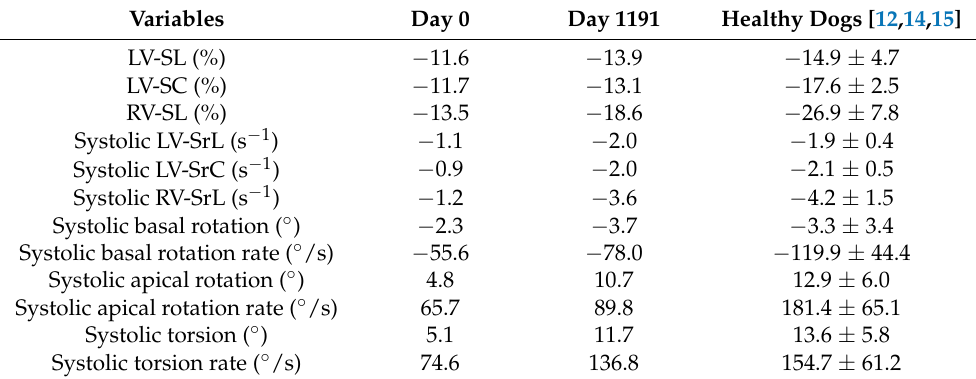
Table 2. Changes in conventional 2D-STE examinations on day 0 and day